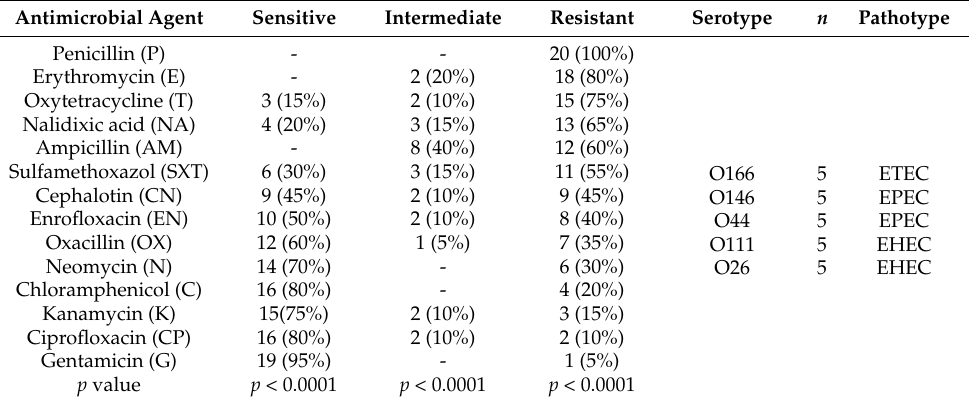
Table 3. Antimicrobial resistance pattern of the isolated E. coli strains from carcass shoulder, carcass brisket, carcass thigh, and abattoir effluent ( n = 20). Antimicrobial Agent Sensitive